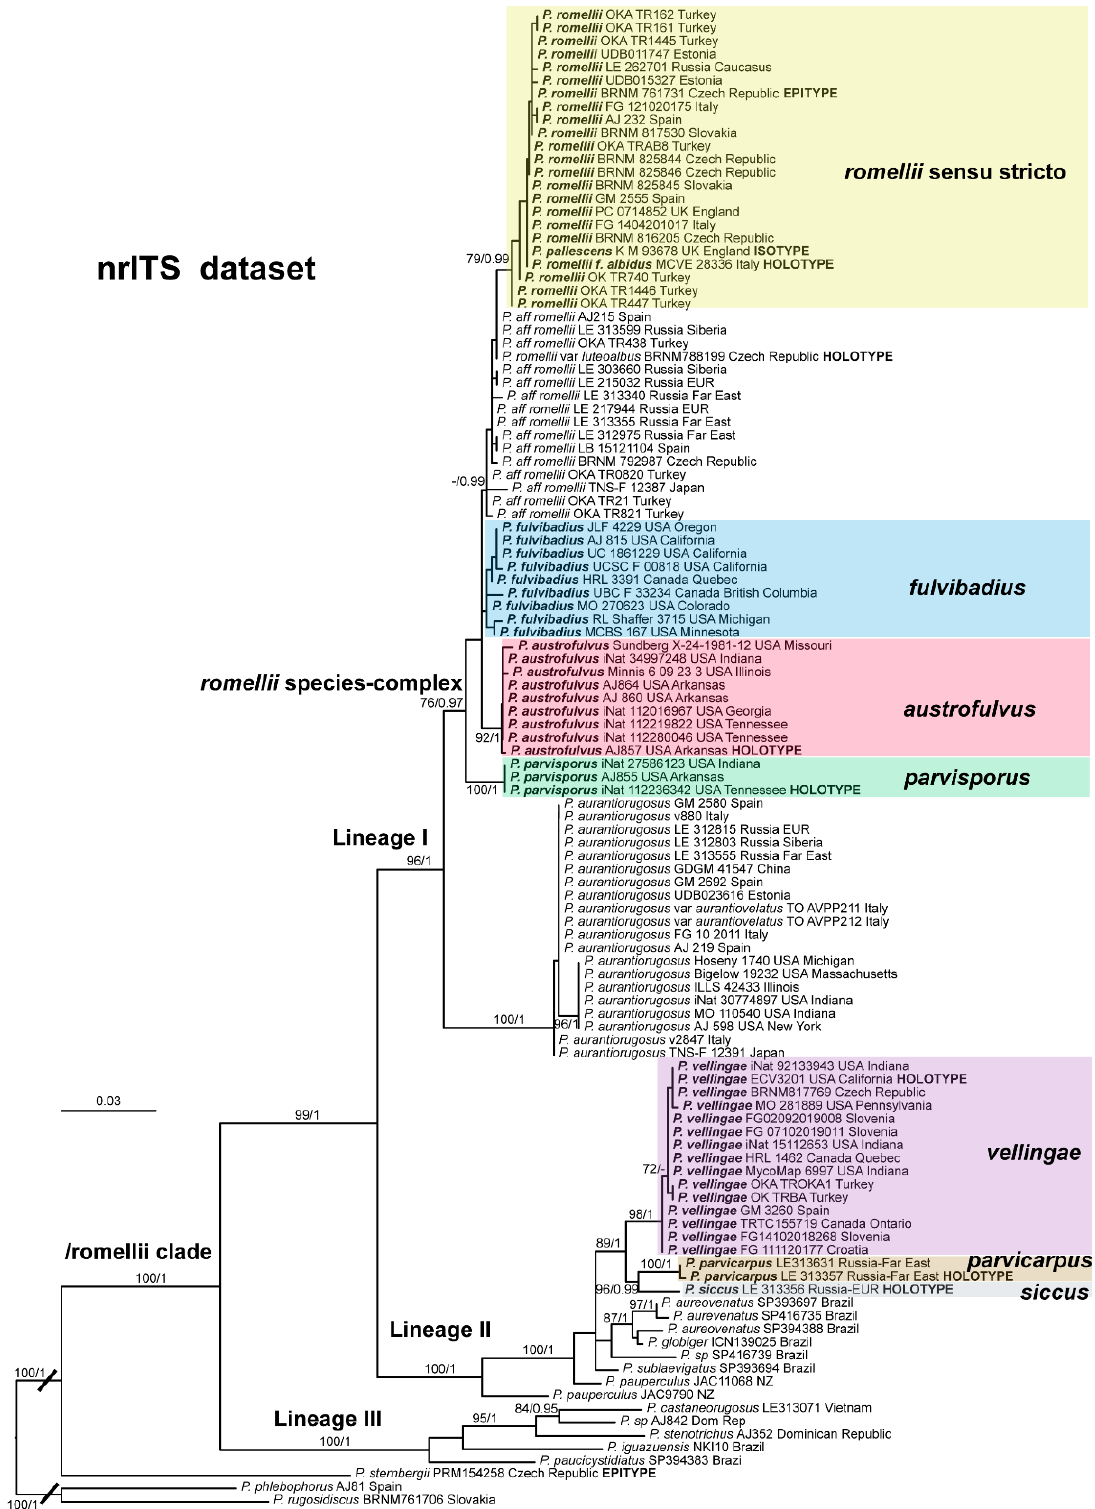
Figure 2. Best tree from the ML analysis of the nrITS dataset. BS values ( ≥ 70%) and PP values ( ≥ 0.90) are shown on or below the branches. Root length has been reduced to accommodate graphical representation. Scale bar indicates the mean number of nucleotide substitutions per site.